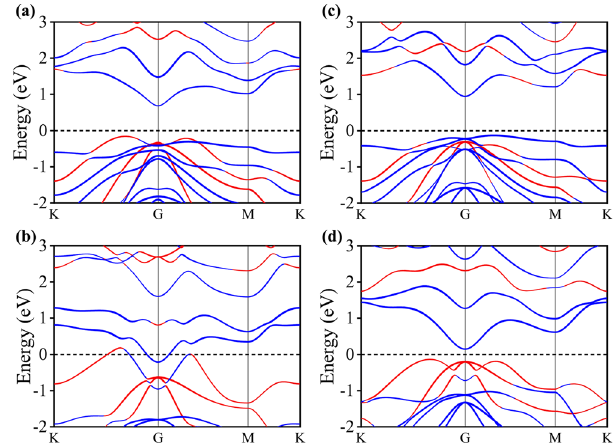
Fig. 2 Layer-projected band structures. The layer-projected band structures of the In 2 Se 3 /SnTe heterostructures. a P ↓ state with Sn – Se interface, b P ↑ state with Sn – Se interface, c P ↓ state with Te – Se interface, d P ↑ state with Te – Se interface. The energy bands projected mainly on In 2 Se 3 and SnTe layers are plotted in blue and red, respectively. The Fermi level is set to 0